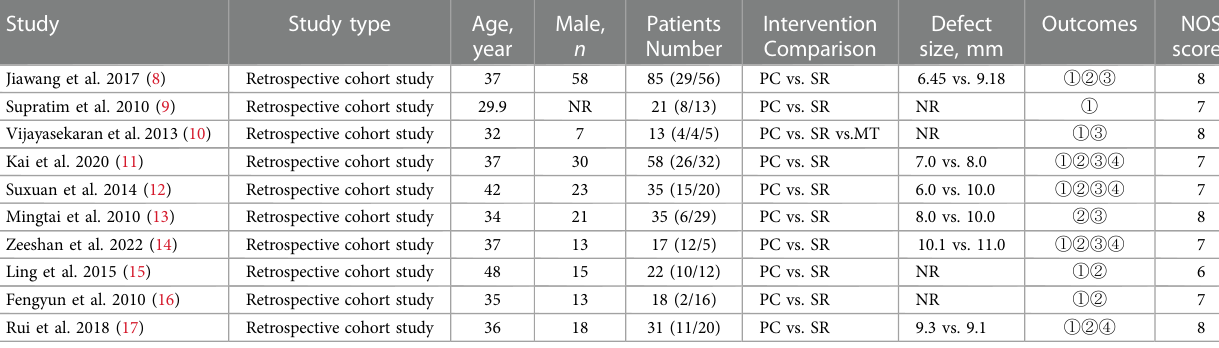
TABLE 2 Descriptive characteristics of the included studies.